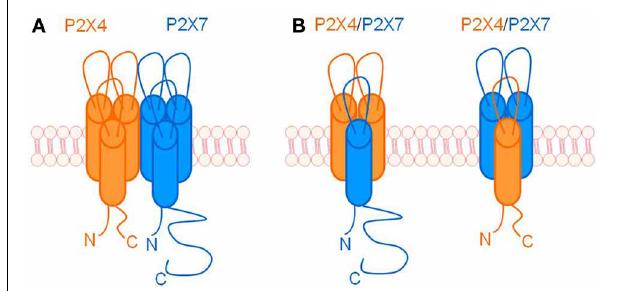
FIGURE 1 | Schematic representation of ways in which P2X4 and P2X7 may interact. (A) Individual P2X4 and P2X7 homotrimers physically associating with one another, possibly via C-terminal tail interactions or intermediate scaffolding proteins. (B) P2X4 and P2X7 subunits forming heterotrimeric